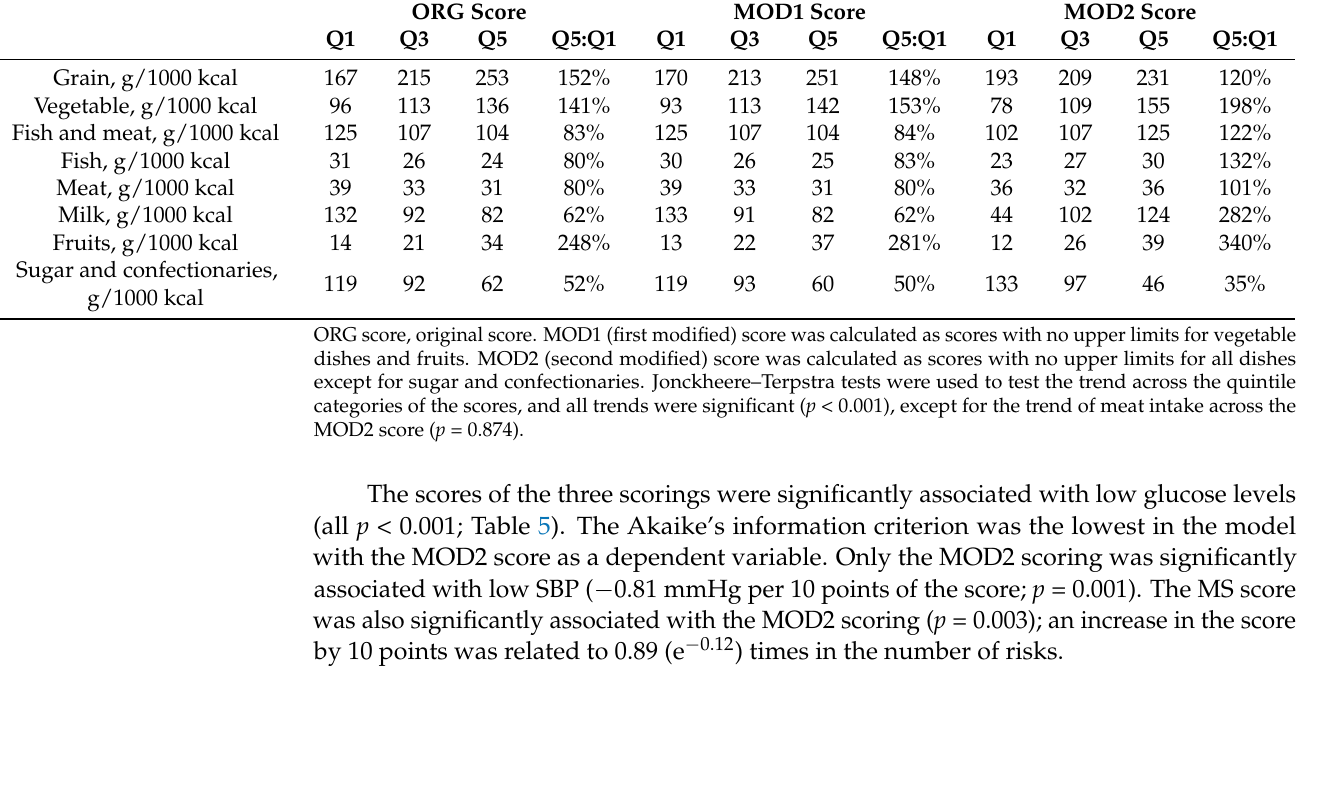
Table 2. Diet quality scoring based on the Japanese Food Guide Spinning Top for adolescents ( n = 3162). Applying Both Upper and Lower Limits Median Min. Max. Min.